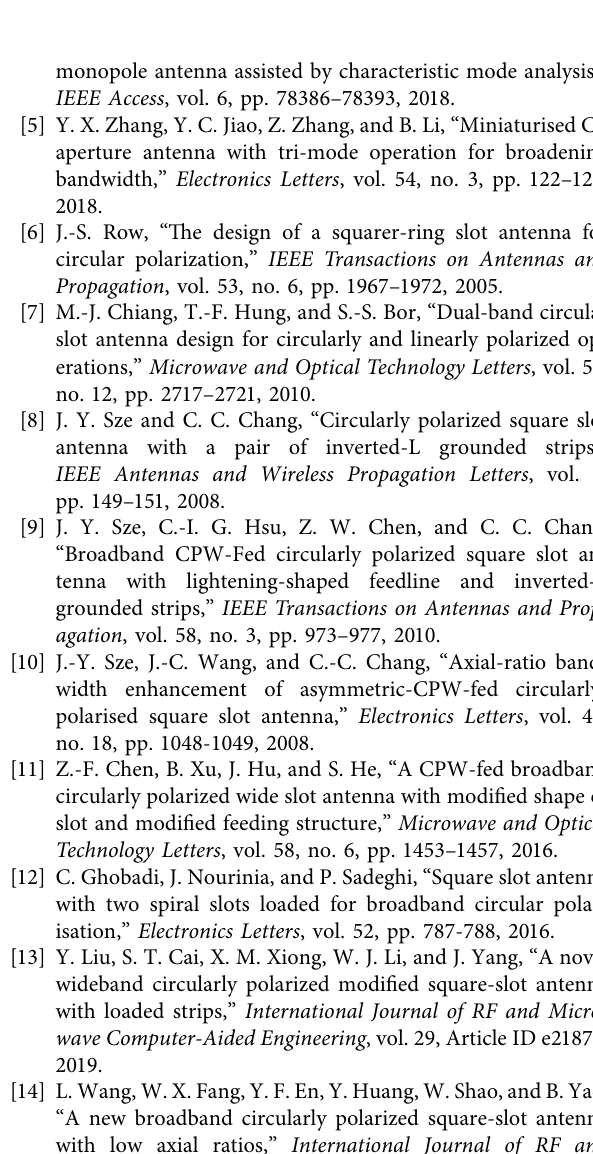
Figure 8: Simulated and tested normalized radiation patterns with different frequency points at (a) 3.45GHz and (b)